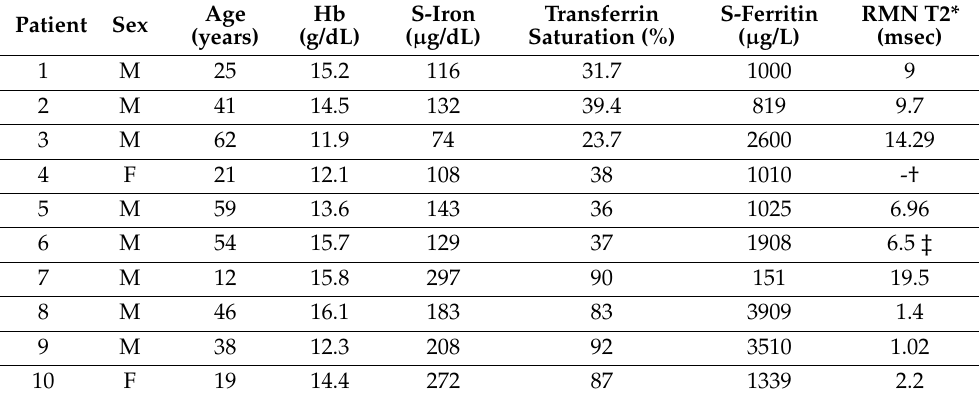
Table 3. Age, hemoglobin, serum iron indices and liver iron concentration of the 10 patients carrying mutations in SLC40A1 , TFR2 , HJV and HAMP .